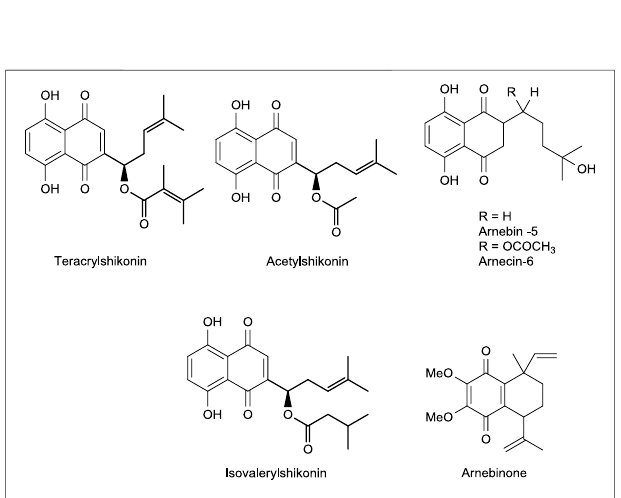
FIGURE 7 | Shikonin derivatives with potent anti-in fl ammatory activity (Singh et al., 2003).